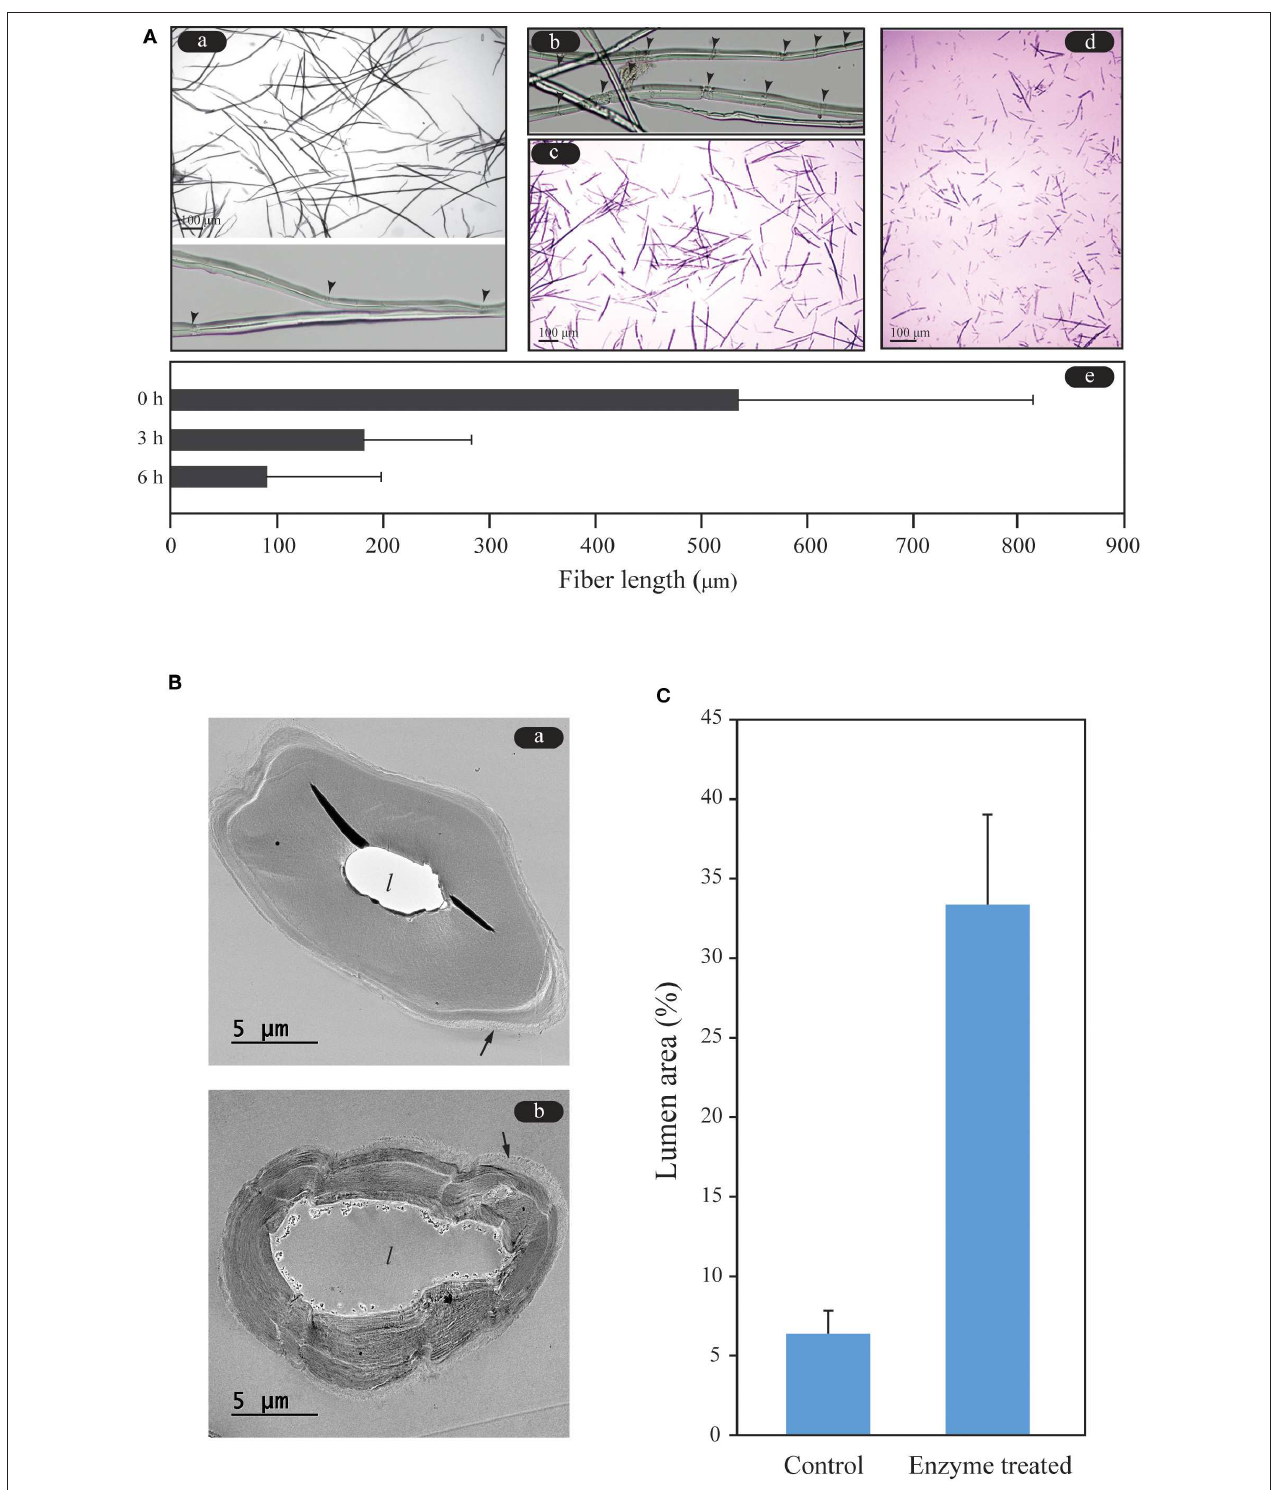
FIGURE 6 | Fiber cutting and hydrolysis patterns of wood fibers of Q. acutissima . (A) Investigation of the fiber length during enzymatic hydrolysis. Cracks (dislocation sites) and fiber cutting were observed at the early stage of the enzymatic hydrolysis. Arrow heads denote the remarkable cracks. a , 0h; b , 30min; c , 3h; d , 6h; e , comparison of fiber lengths. (B) Analysis of the hydrolysis pattern of wood fiber. Degradation occurred more rapidly in the inner part of the wood fiber than in the outer part of the fiber. The arrow and l denote the outermost (primary wall) layer of the wood fiber and lumen, respectively. a , no enzyme treatment of HPAC-treated wood fiber; b , enzyme-treated. (C) Ratio of the lumen area to the sectional area of the fiber.